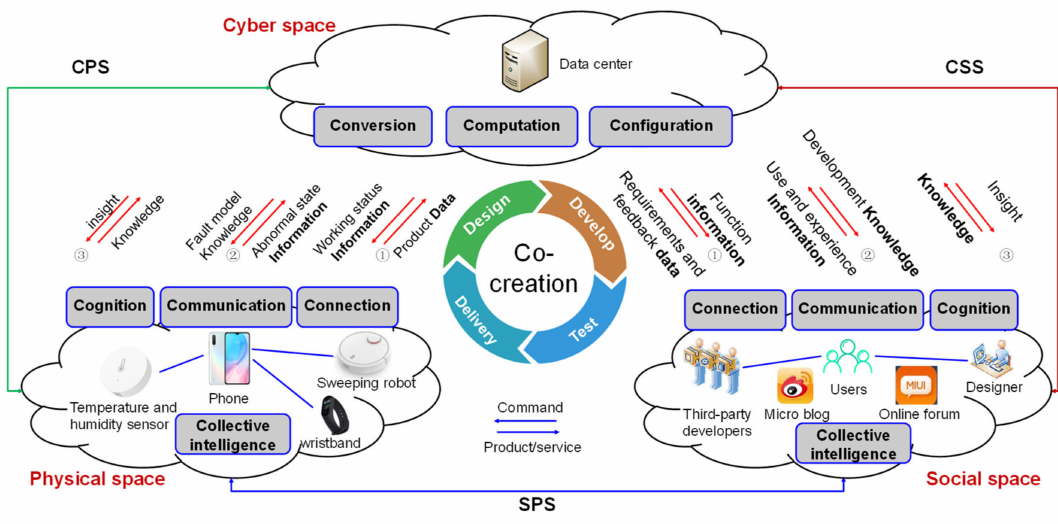
Figure 5. The application scenario of 7C framework for